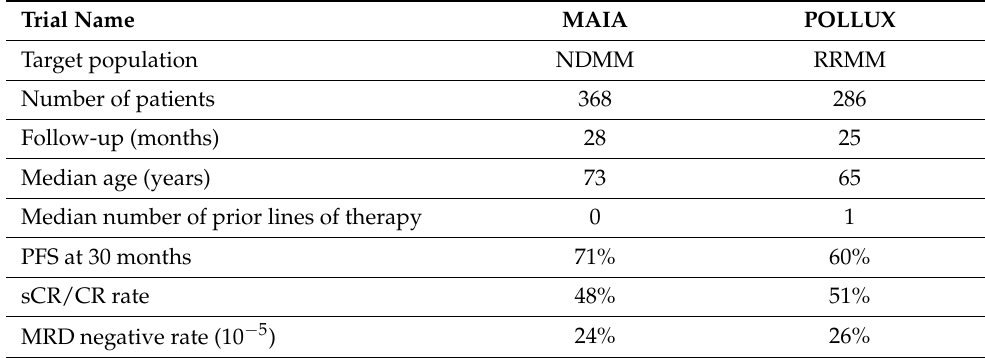
Table 3. Results of treatment with Daratumumab, lenalidomide and